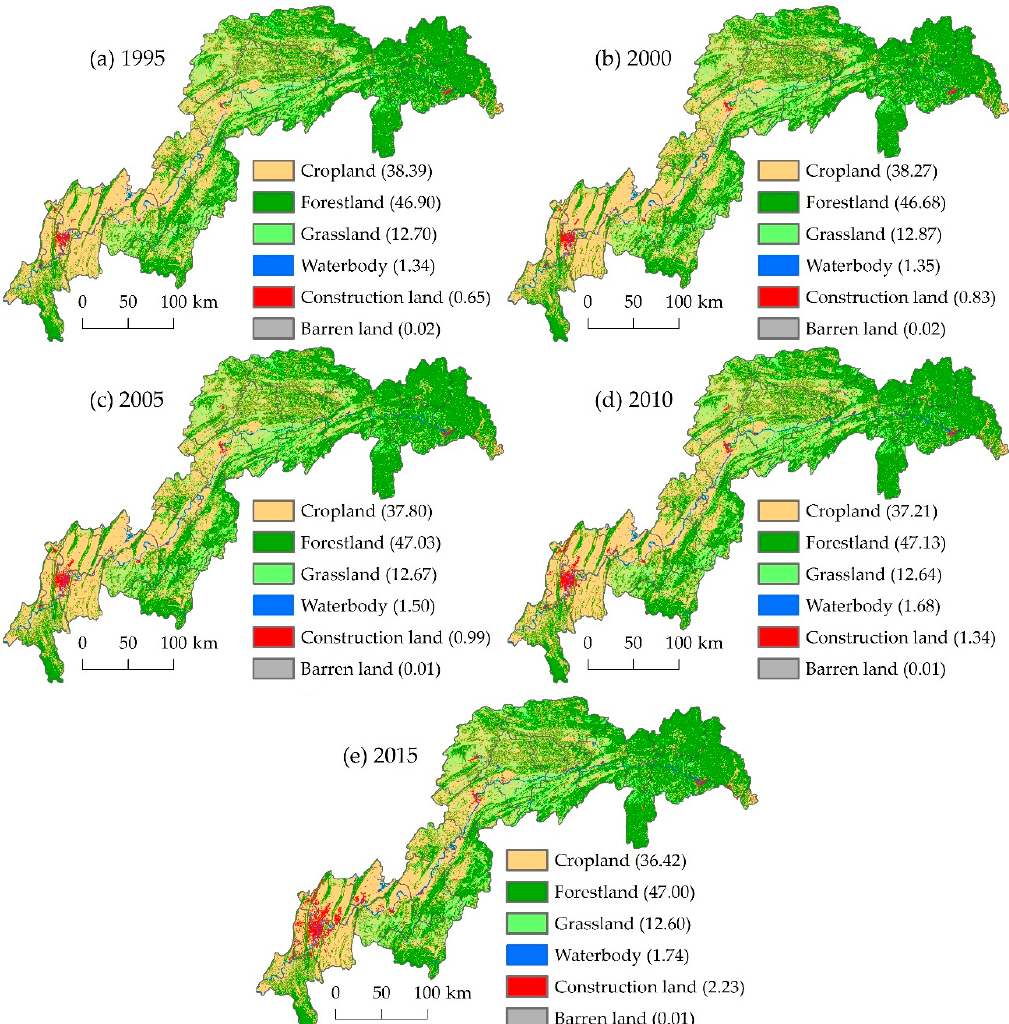
Figure 3. Land use/cover maps in the Three Gorges Reservoir Area for ( a ) 1995, ( b ) 2000, ( c ) 2005, ( d ) 2010, and ( e ) 2015. The data is sourced from references [58,62], which can be downloaded from the Resource and Environment Data Cloud Platform. The number in parentheses is the area percentage of each land use type.